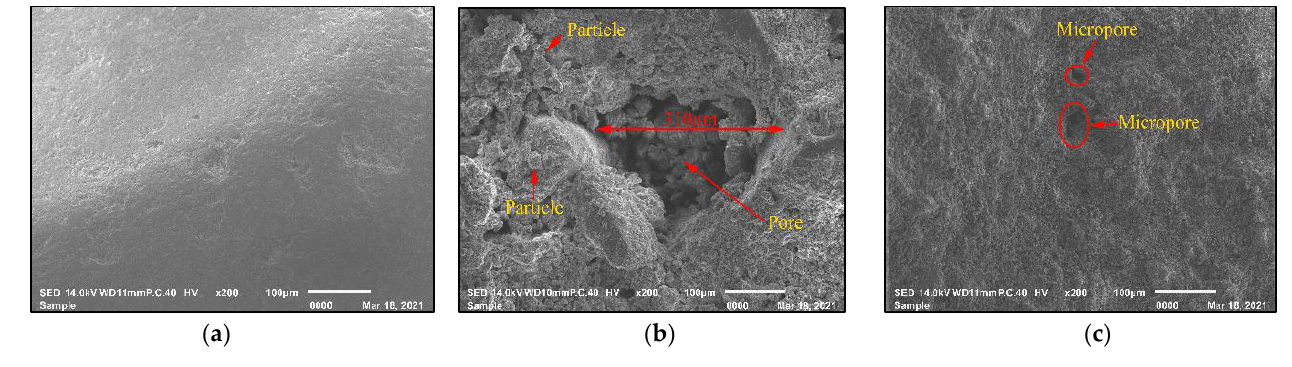
Figure 3. SEM images of ( a ) NFA, ( b ) RFA1 and ( c ) RFA2.